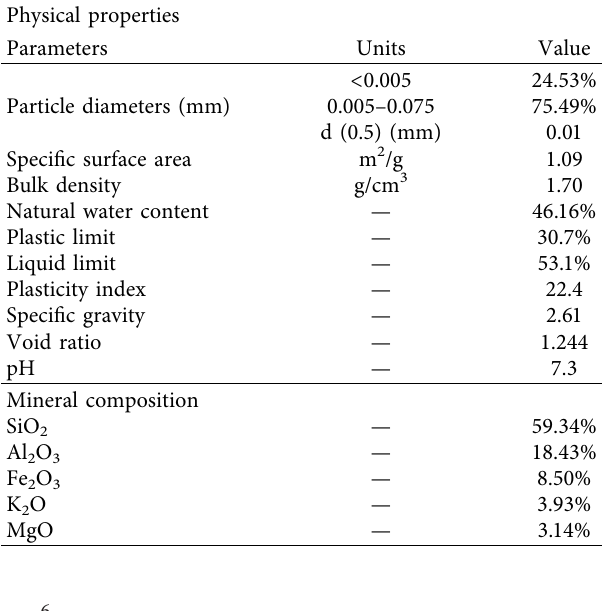
Table 1: Physical index and mineral composition.